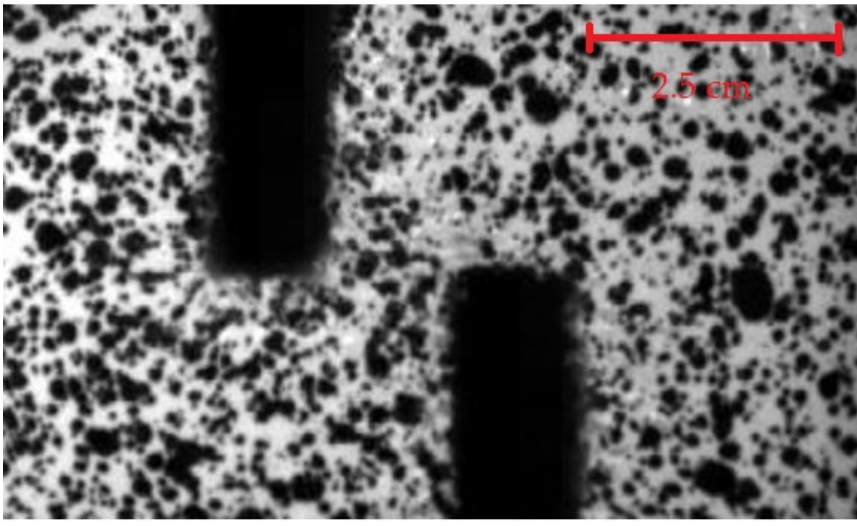
Figure 3. NSSS with a random speckled pattern.